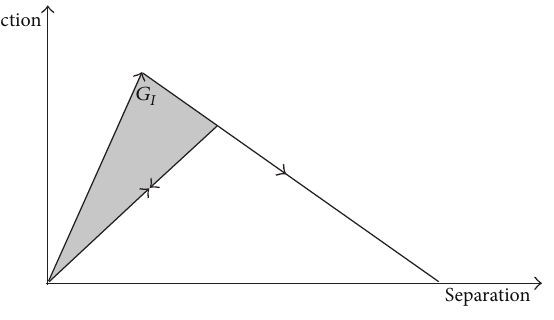
Figure 3: Damage evolution of CFRP.